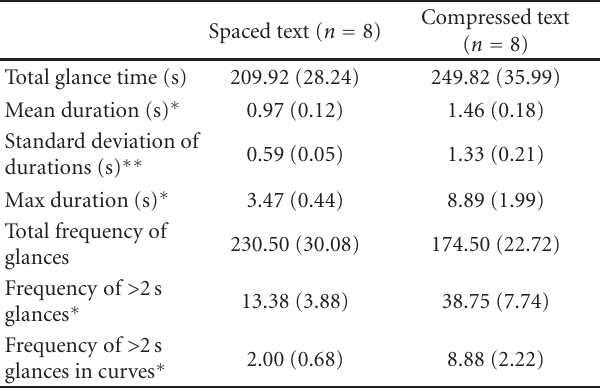
Table 1: Experiment 1: mean values of glance measures to the text display (standard